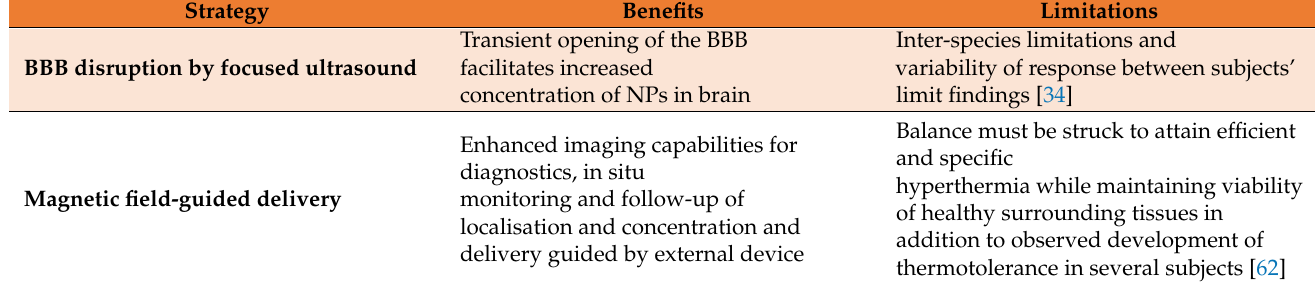
Table 1. Main strategies for nanotheranostic drug delivery to the brain across the BBB. Strategy BBB disruption by focused